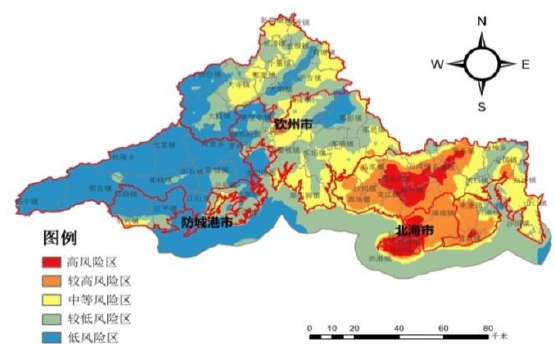
Figure 7. Distribution of comprehensive ecological risk grades in Guangxi coastal